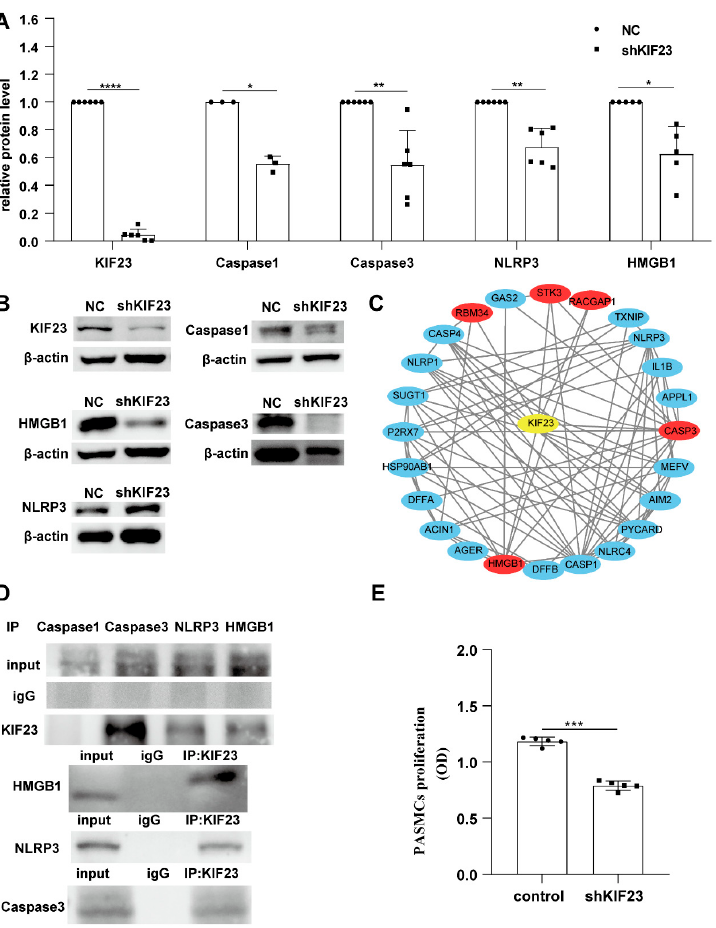
Figure 6. The effect of KIF23 knockdown on PASMCs pyroptosis. ( A , B ) The protein level of KIF23, Caspase1, Caspase3, NLRP3, and HMGB1 between NC and shKIF23 groups. n = 5 per group. * p < 0.05, ** p < 0.01, *** p < 0.001, **** p < 0.0001 versus NC. Data are mean ± SEM. ( B ) The predicted protein interactions of KIF23, Caspase3, NLRP3, and HMGB1. ( C ) PRGs that may interact with KIF23. ( D ) Co-IP results showed that KIF23 interact with Caspase3, NLRP3, and HMGB1. ( E ) The effect of KIF23 knockdown on PASMCs